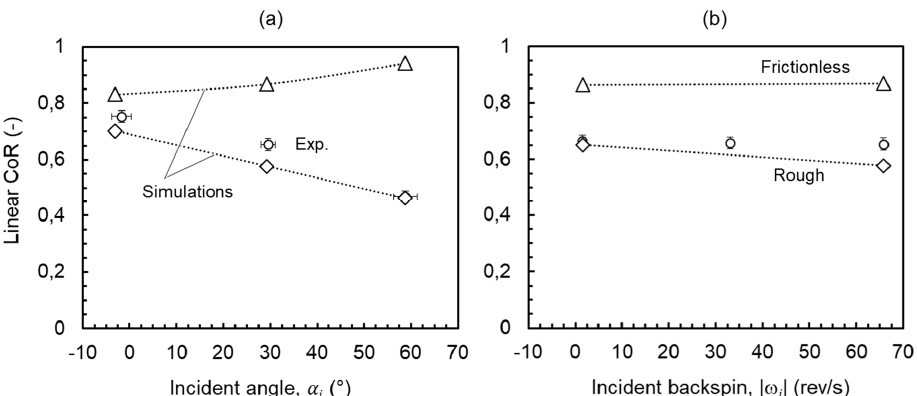
Figure 11. Effect of the ball/foam contact properties on the predicted linear coefficient of restitutions. ( a ) Foam impacted at varying incidence and constant velocities (V i = 14 m/s and ω i = − 66 rev/s). ( b ) Foam impacted at varying incident backspin and constant angle ( α i = 30°) and linear velocity (V i = 14 m/s).